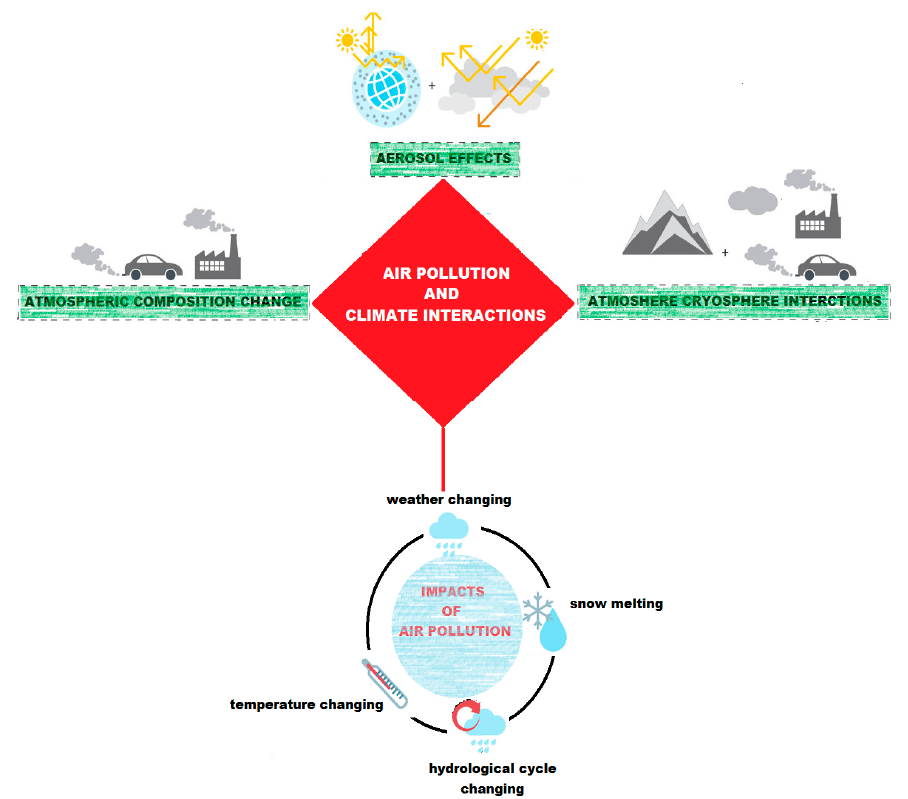
Figure 1. Flowchart diagram of air pollution interaction and impacts.